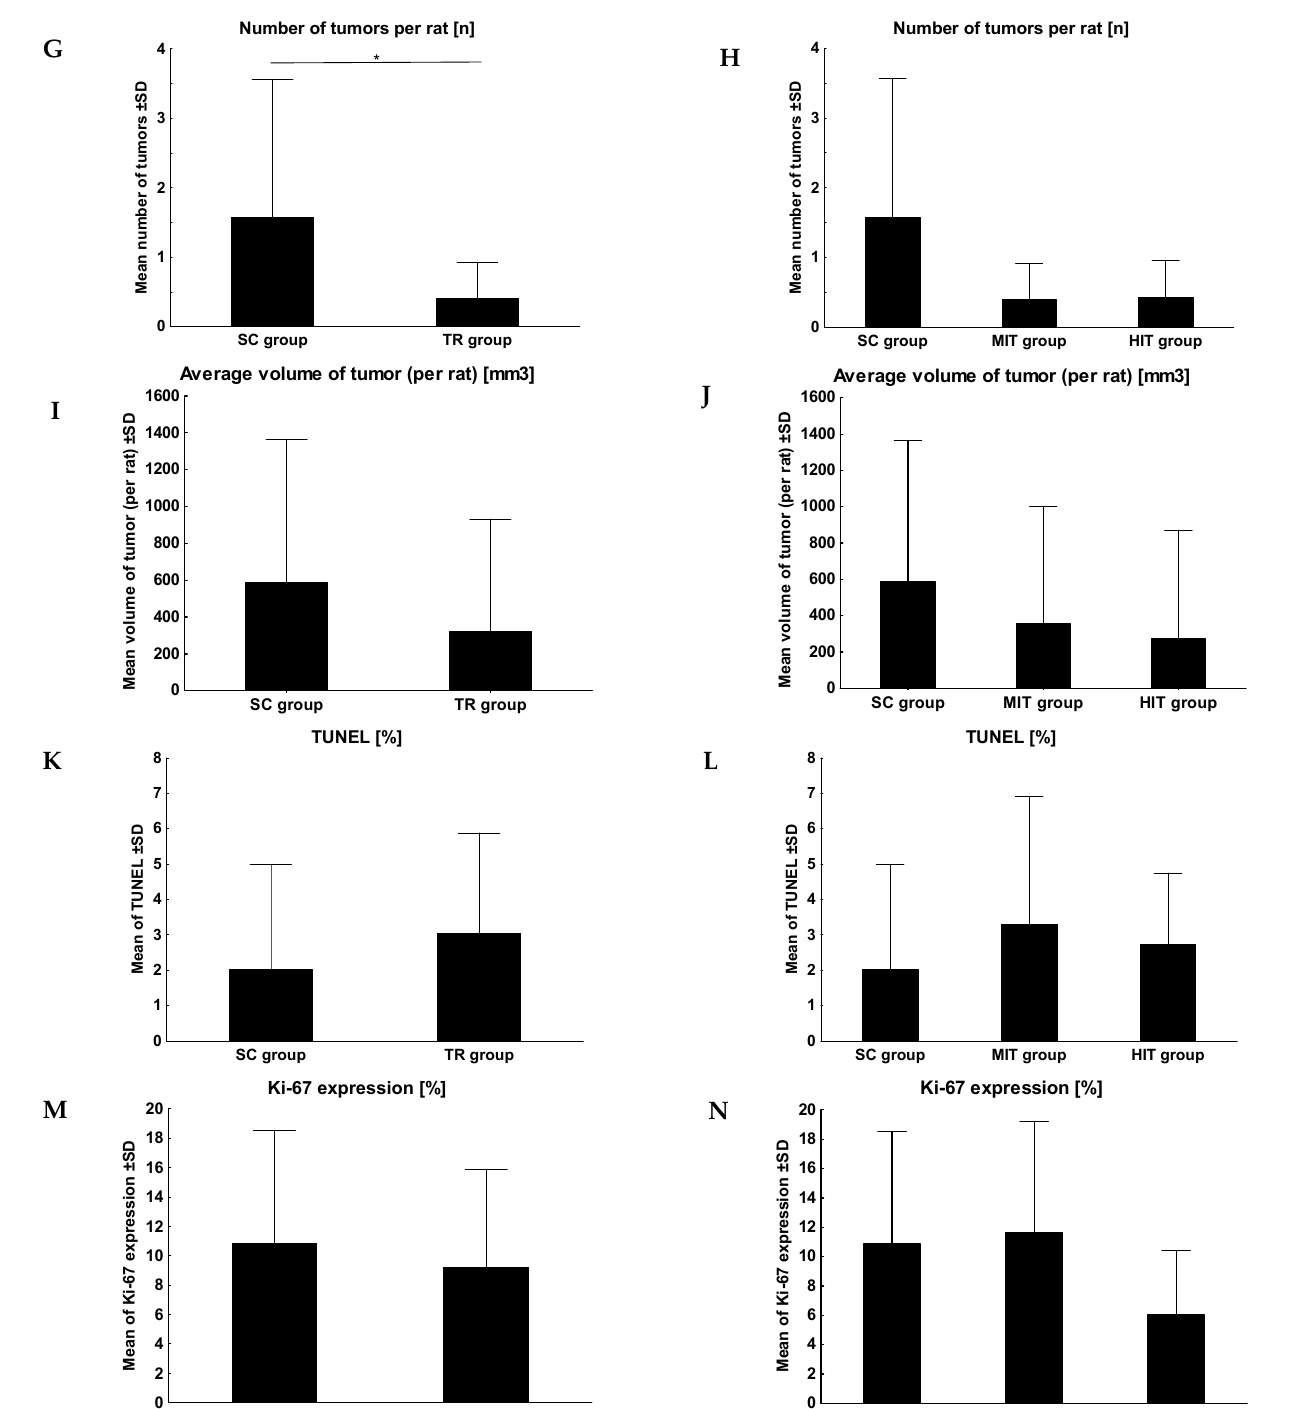
Figure 1. Clinicopathological parameters of the animals included body weight at the time of MNU administration ( A , B ), the dose of MNU ( C , D ), body weight at necropsy ( E , F ), number of tumors per rat ( G , H ), tumor volume ( I , J ), number of apoptotic cells ( K , L ) and the intensity of Ki-67 proliferation ( M , N ) in the study groups. Data were analyzed using the Mann–Whitney U test to compare the sedentary group (SC, n = 14) with the combined training groups (TR = MIT + HIT, n = 24) and the Kruskal–Wallis test was applied for the analysis in particular groups (SC, n = 14, MIT, n = 12, HIT, n = 12). *—the level of divergence between groups ( p < 0.05); Mann–Whitney U test.